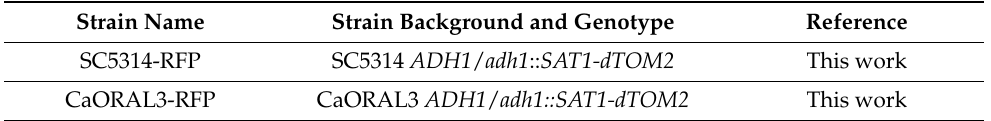
Table 1. C. albicans strains used in this